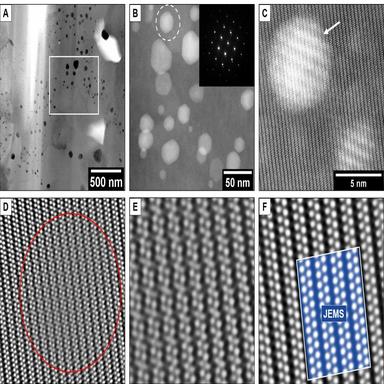
(A) STEM-HAADF image of the bottom part of the chromia scale formed on the 718Plus superalloy oxidized at 850 °C for 4000 h; (B) selected area highlighting the presence of γ particles in the chromia scale (STEM-HAADF) with the corresponding electron diffraction pattern for the area marked with the white dashed circle; (C) High-resolution STEM-HAADF image of fine γ particles within the chromia scale; (D) Filtered high-resolution STEM-HAADF image of the particle pointed out in C; (E) Filtered high-